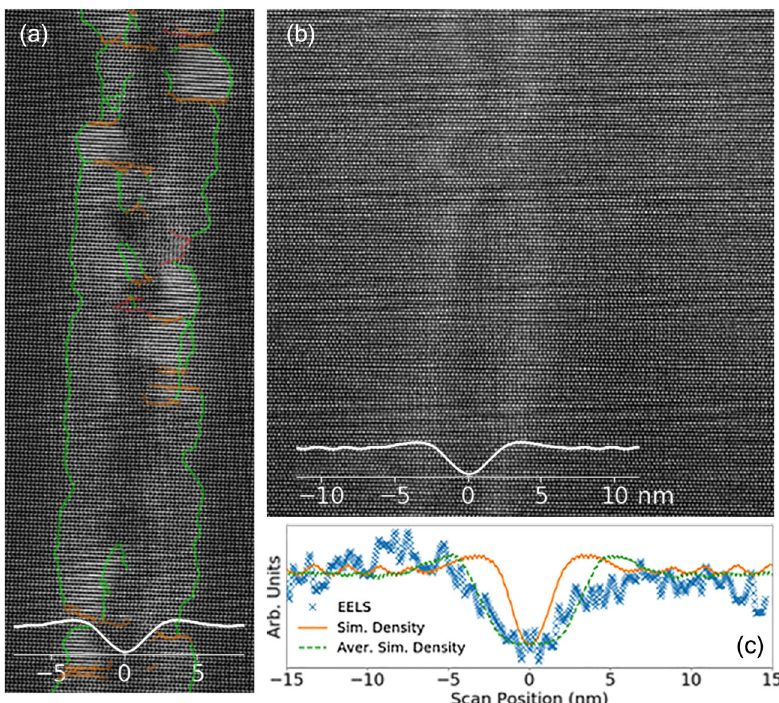
Fig. 3 Cross-sectional images of the fi nal state of the 185MeV Au ion track in the deeper regions. a Simulated track with the green and orange lines representing the dislocation edges and stacking faults, respectively, as obtained from the dislocation extraction algorithm analysis. b Experimental cross- sectional transmission electron microscopy – high-angle annular dark- fi eld image. c Simulated and experimental density pro fi les (also overlayed in ( a ) and ( b )). The dashed line corresponds to the average of the simulated pro fi le over a window of multiple slices, as a means to introduce the experimental resolution (see